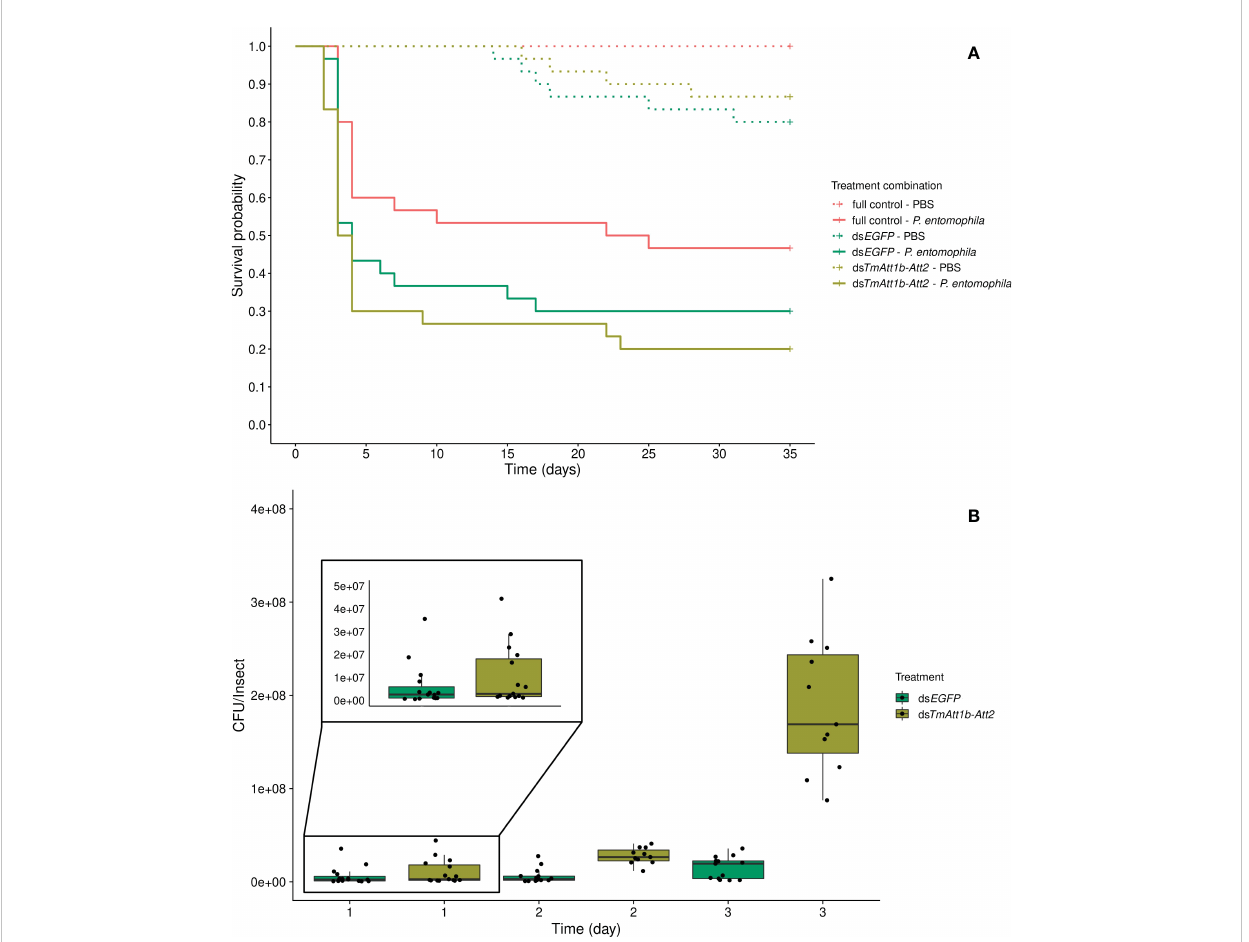
FIGURE 5 (A) Effect of TmAttacin1b-2 ( TmAtt1b-Att2 ) double-knockdown on survival of Pseudomonas entomophila infected Tenebrio molitor females over